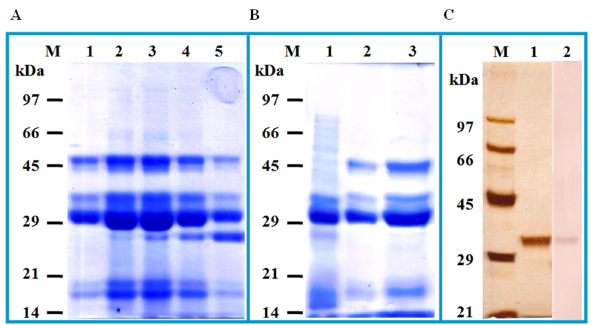
Figure 1. Protein profile of eluted fractions containing 31 kDa as a major eluted kidney bean protein. Kidney bean extract was subjected to anion exchange chromatography (A). Lane 1 2 5: fractions (10 to 14). Protein profile of gel filtration eluted fractions containing 31 kDa as a major eluted protein (B). Lane 1 2 3: fractions (17 to 19). Elution profile of purified 31 kDa protein after HPLC (C). Lane 1: purified protein after silver staining on SDS-PAGE, lane 2: immunoblot of purified protein using kidney bean hypersensitive pooled patients’ sera.